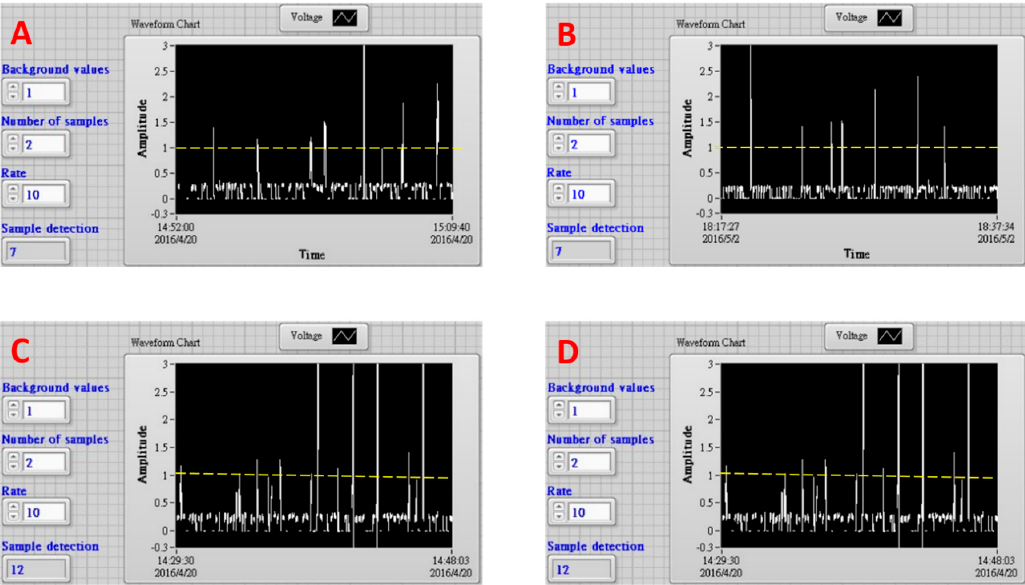
Figure 4. Temporal fluorescence signal traces during droplet sorting processes using EWOD device. Frame ( A ): sample aliquot containing about 10 fluorescent microspheres (1000 μ L); Frame ( B ): the same sample solution as that in A of 1200 μ L aliquot; Frame ( C ): sample aliquot containing about 25 fluorescent microspheres (1200 μ L); Frame ( D ). the same sample solution as that in C of 400 μ L aliquot. The dashed lines in each frame are the cut-off level to actuate the EWOD electrode sets to divert the droplets.